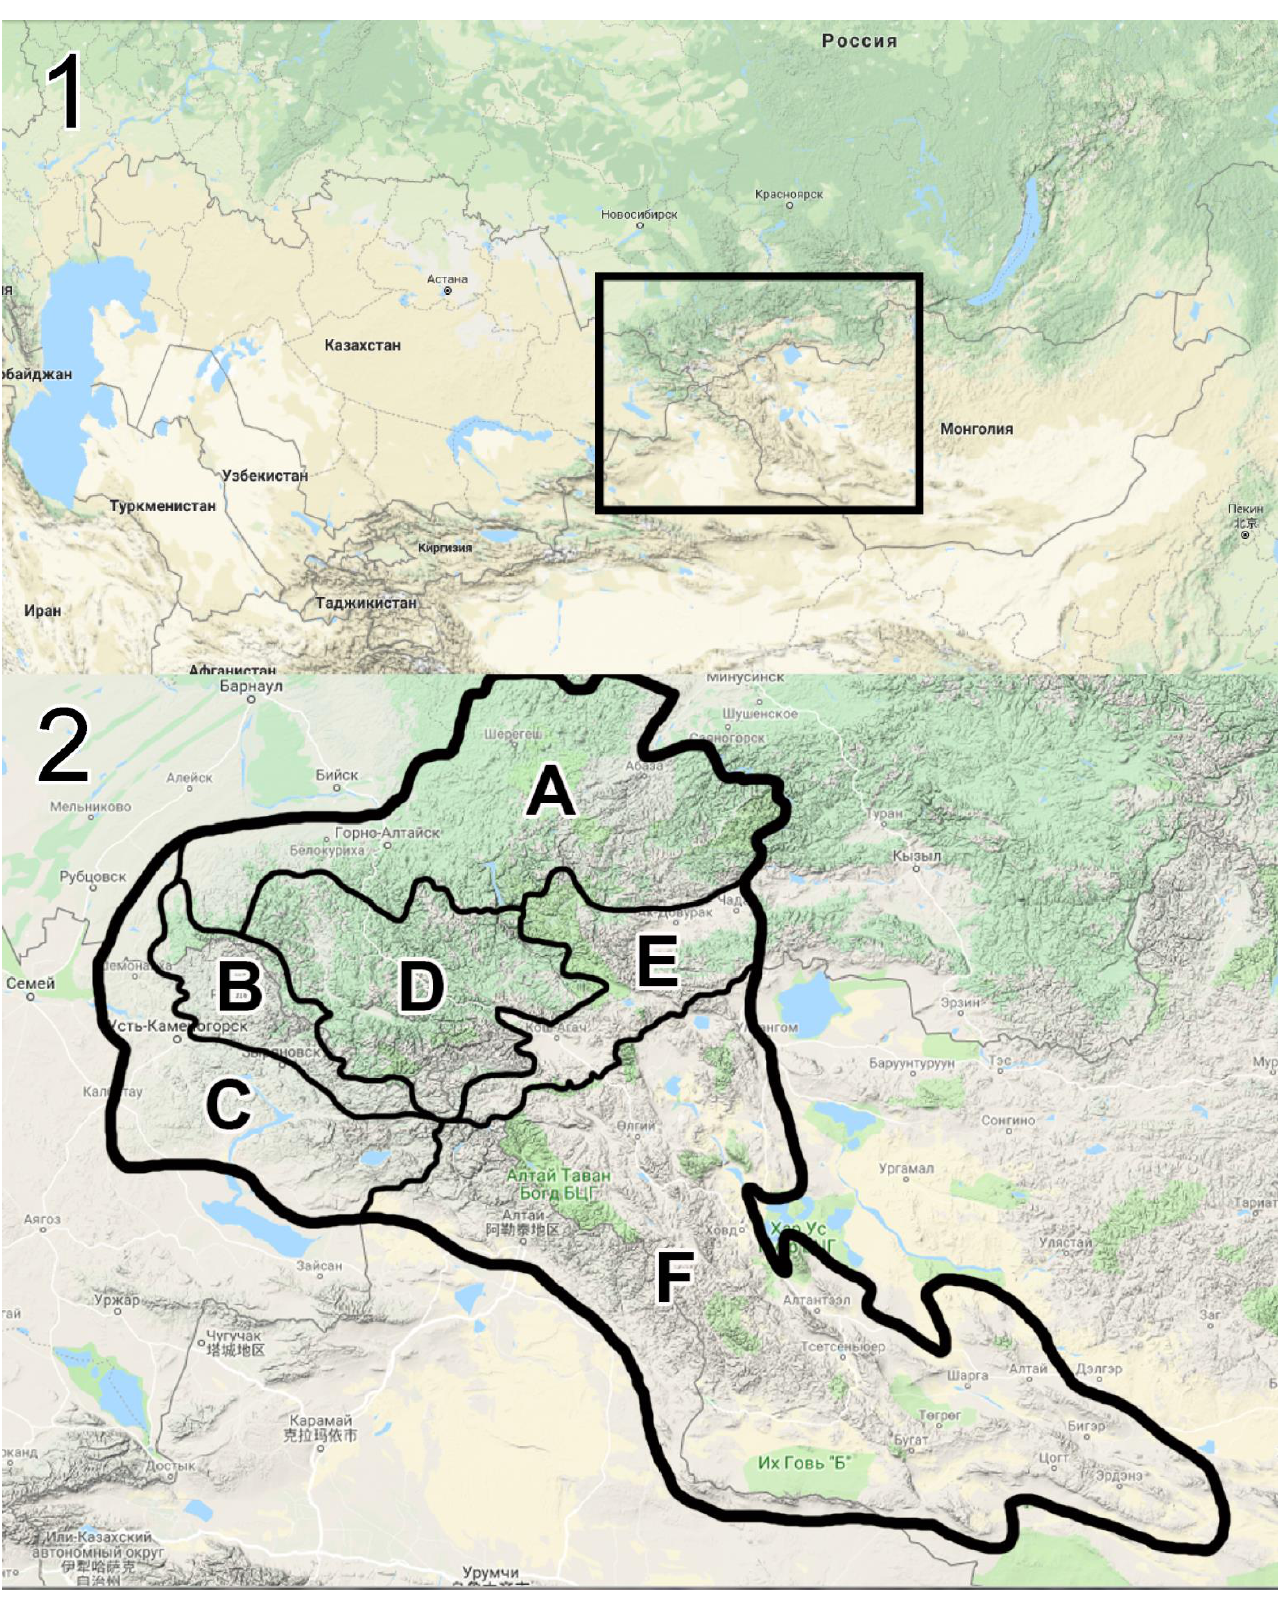
Рис. 1–2. Местоположение Алтайских гор (1) и принимаемое нами деление их на регионы (2). A – Северный Алтай, B – Западный Алтай, C – Южный Алтай, D – Центральный Алтай, E – Юго-Восточный Алтай, F – Монгольский